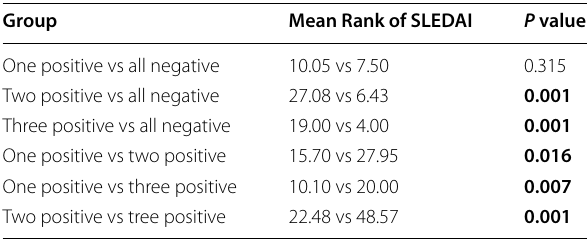
Table 4 Effect of co‑positivity of anti‑dsDNA, anti‑nucleosome, and anti‑smith on SLEDAI score